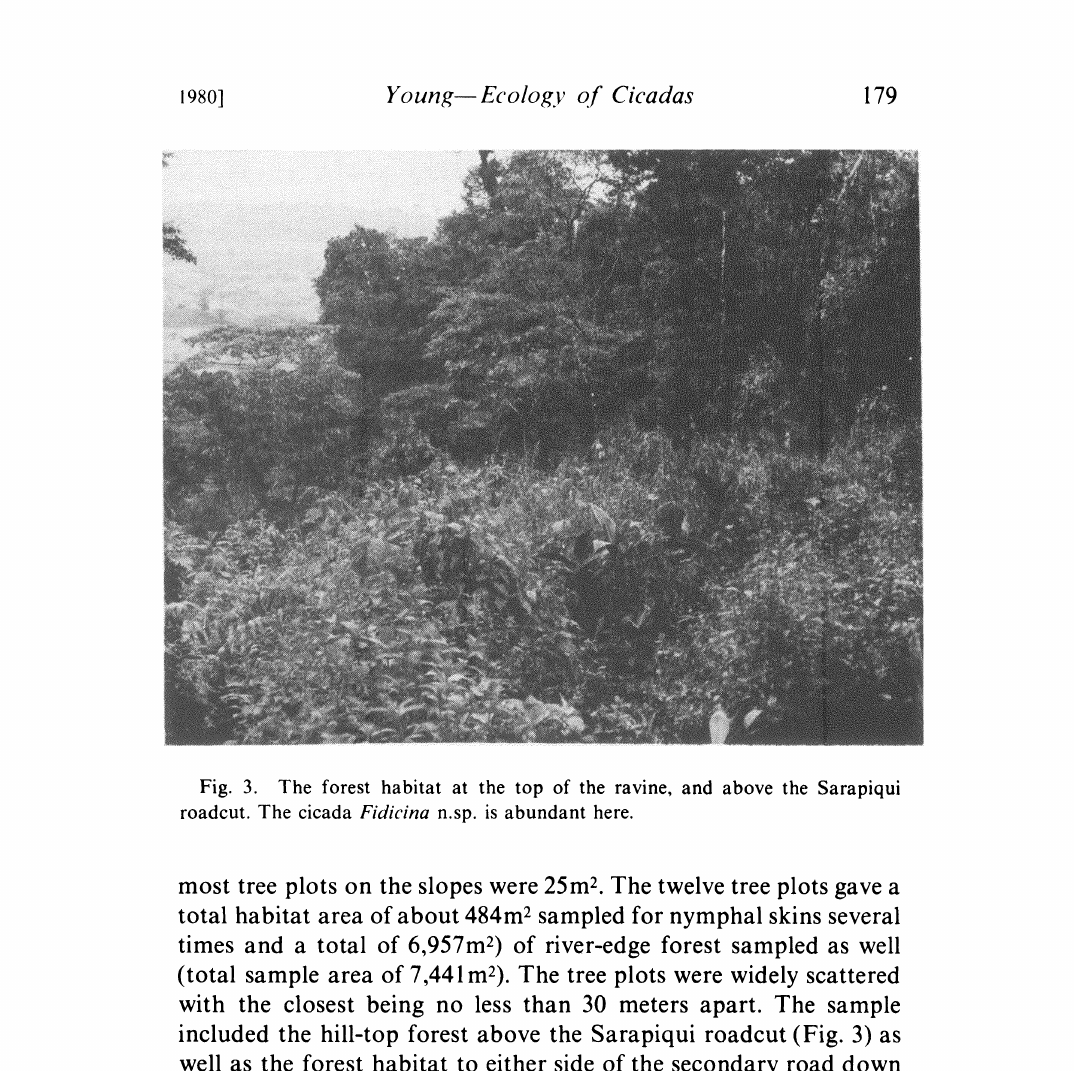
Fig. 3. The forest habitat at the top of the ravine, and above the Sarapiqui roadcut. The cicada Fidicina n.sp. is abundant here. most tree plots on the slopes were 25m 2. The twelve tree plots gave